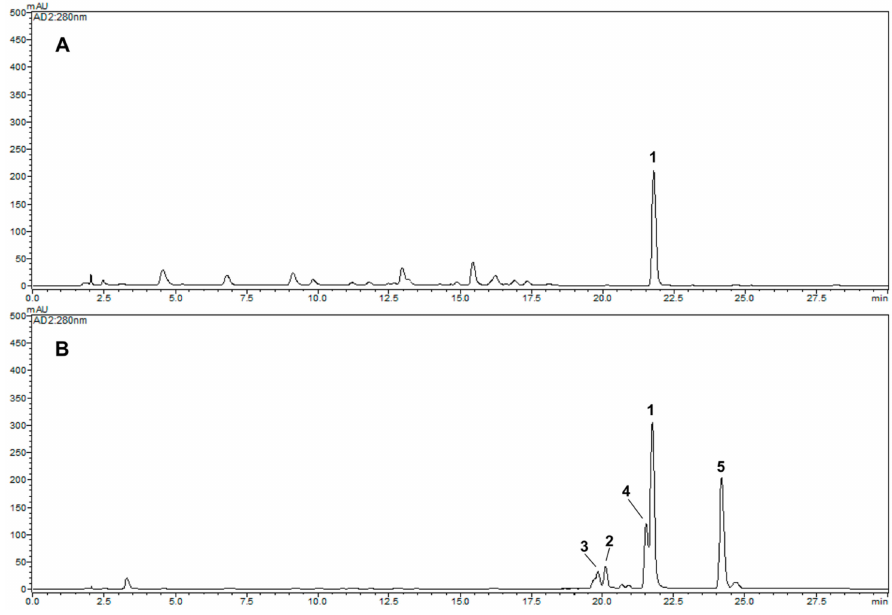
Figure 5. HPLC chromatograms of thermal reactant ( B ) of the Derris root extract ( A ). ( A ) Derris root extract, ( B ) heat-treated reactant for 12 h. 1 : rotenone, 2 : ( − )-rotenolone, 3 : (+)-epirotenolone, 4 : (+)-epirotenone, 5 : dehydrorotenone. Table 2. LC − MS data of the major bioactive constituents identified in thermal-treated Derris root